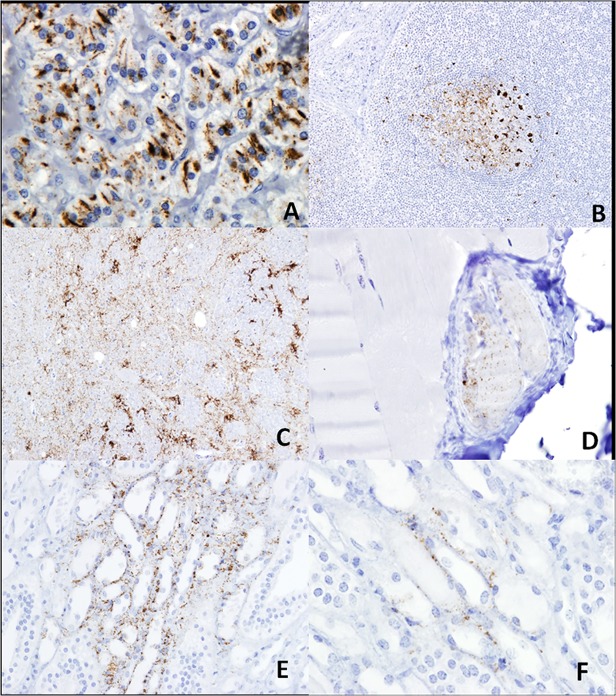
Different levels of abnormal PrP immunolabelling in selected tissues from scrapie positive sheep using R145 as primary antibody and Mayer’s haematoxylin as counterstain.A: Widespread abnormal PrP labelling in the adrenal gland from B1216 (original magnification ×20). B: Abnormal PrP in the secondary follicles of the prescapular lymph node from B1217 (original magnification ×10). C: Widespread distribution of Abnormal PrP in the obex from B1217 (original magnification ×10). D: Very localised deposition of Abnormal PrP in the spindles of the semitendinous muscle from B1216 (original magnification ×40). E and F: examples of different level of deposition of PrPd in the renal papillae from respectively B1223 and B1217 (original magnification E ×20 and F×40).